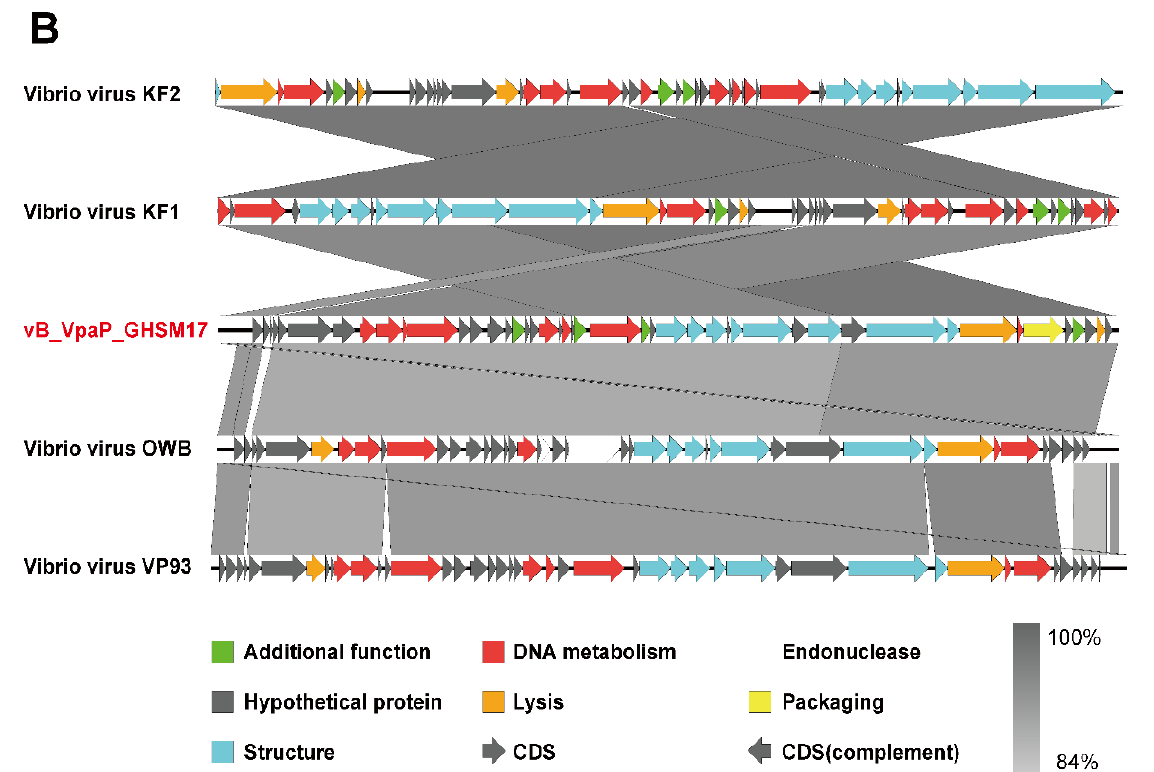
Figure 5. Genomic characterization of vB_VpaP_GHSM17. ( A ) Schematic diagram of GHSM17. From inside to outside, the first to third circles represent the scale, GC Skew, and GC content, respec- tively; the fourth and fifth circles represent the positions of CDS, tRNA, and rRNA on the genome. ( B ) Schematic representation of the genomic organization of GHSM17 compared to all four classified species in genus Maculvirus , family Autographiviridae.